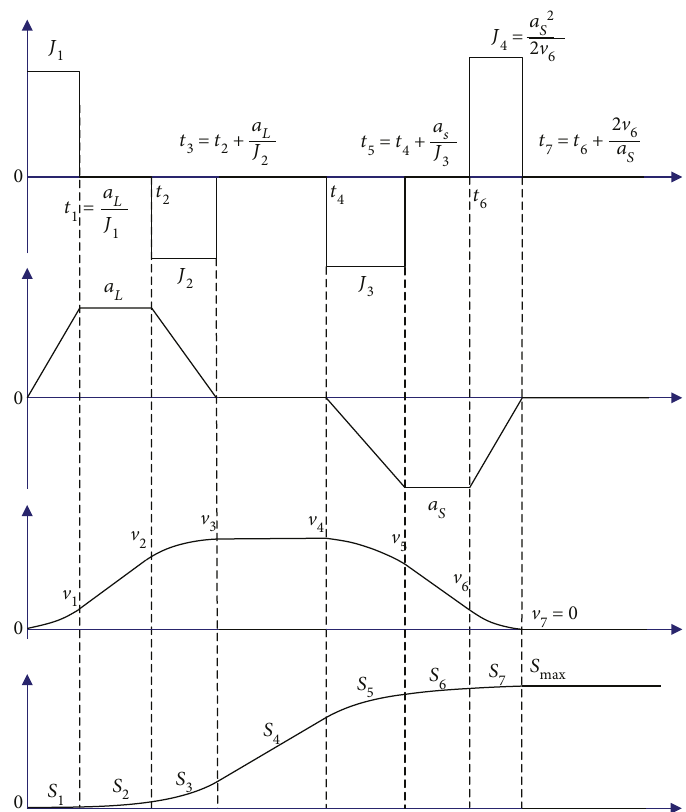
Figure 2: S-curve motion pro fi les and